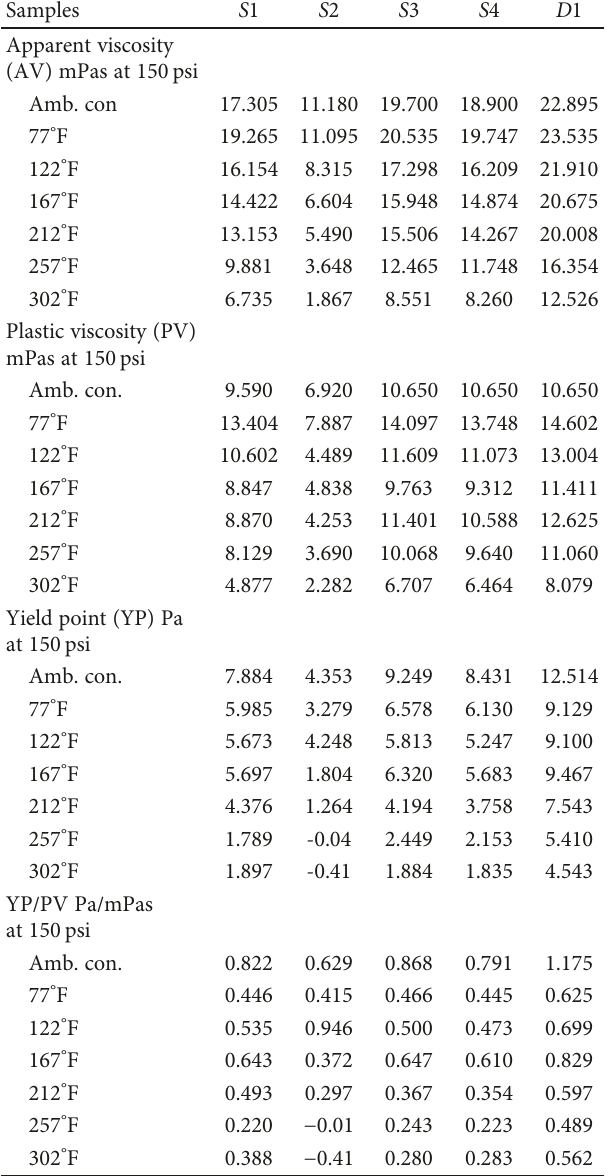
Table 3: The other rheological properties of the drilling mud